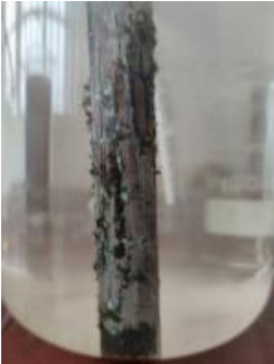
Figure 2. Uneven rust spots on surface of steel bars in simulated pore solutions of